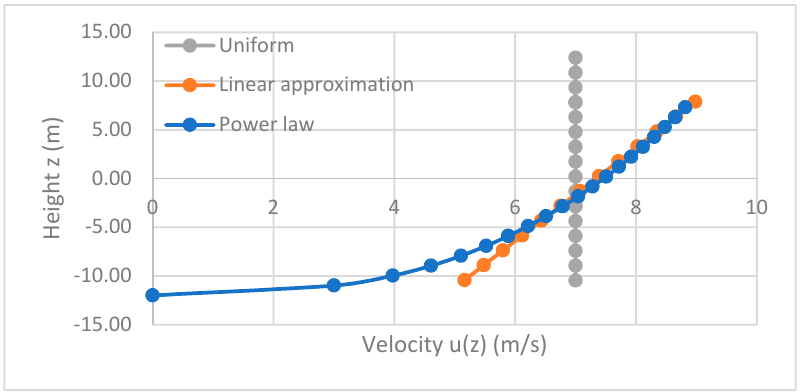
Figure 14. Different inflow conditions. Figure 14. Di ff erent inflow conditions.